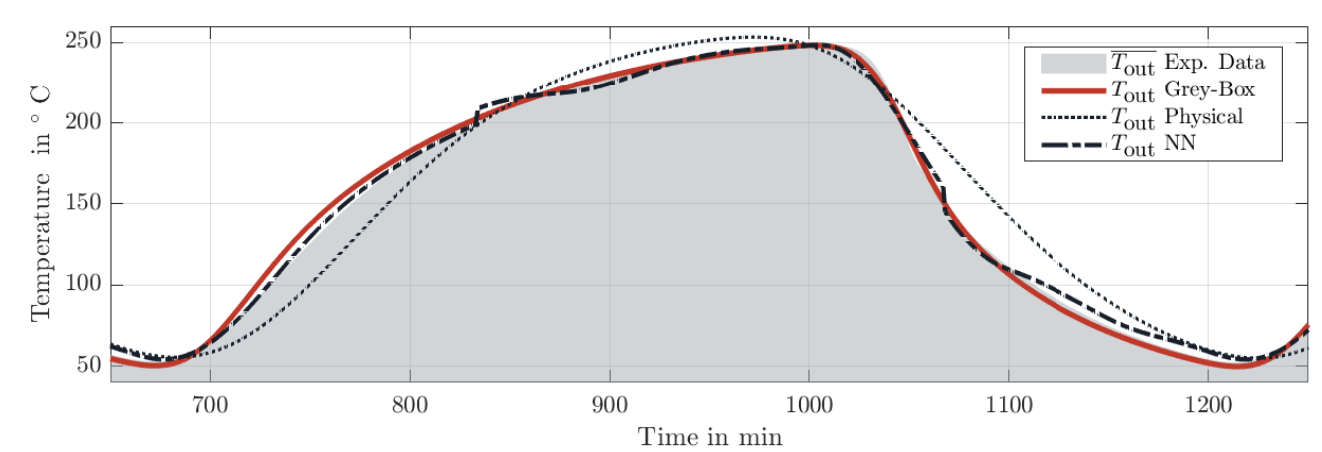
Figure 6. Results of the extended grey-box model II, physical, and NN model for one cycle of measurement series